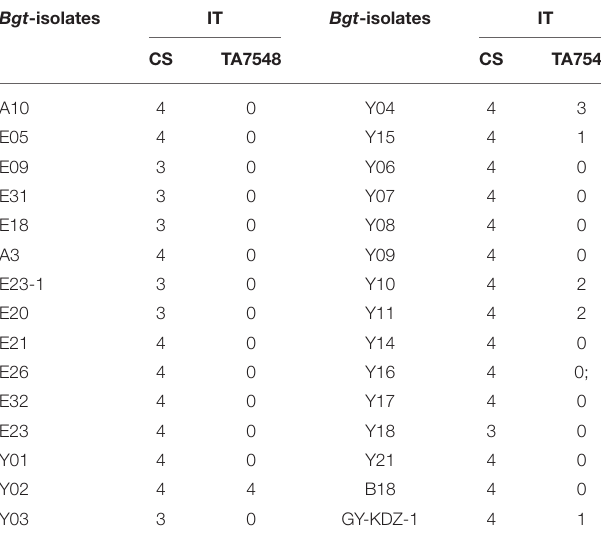
TABLE 1 | Responses of TA7548 to 30 Bgt